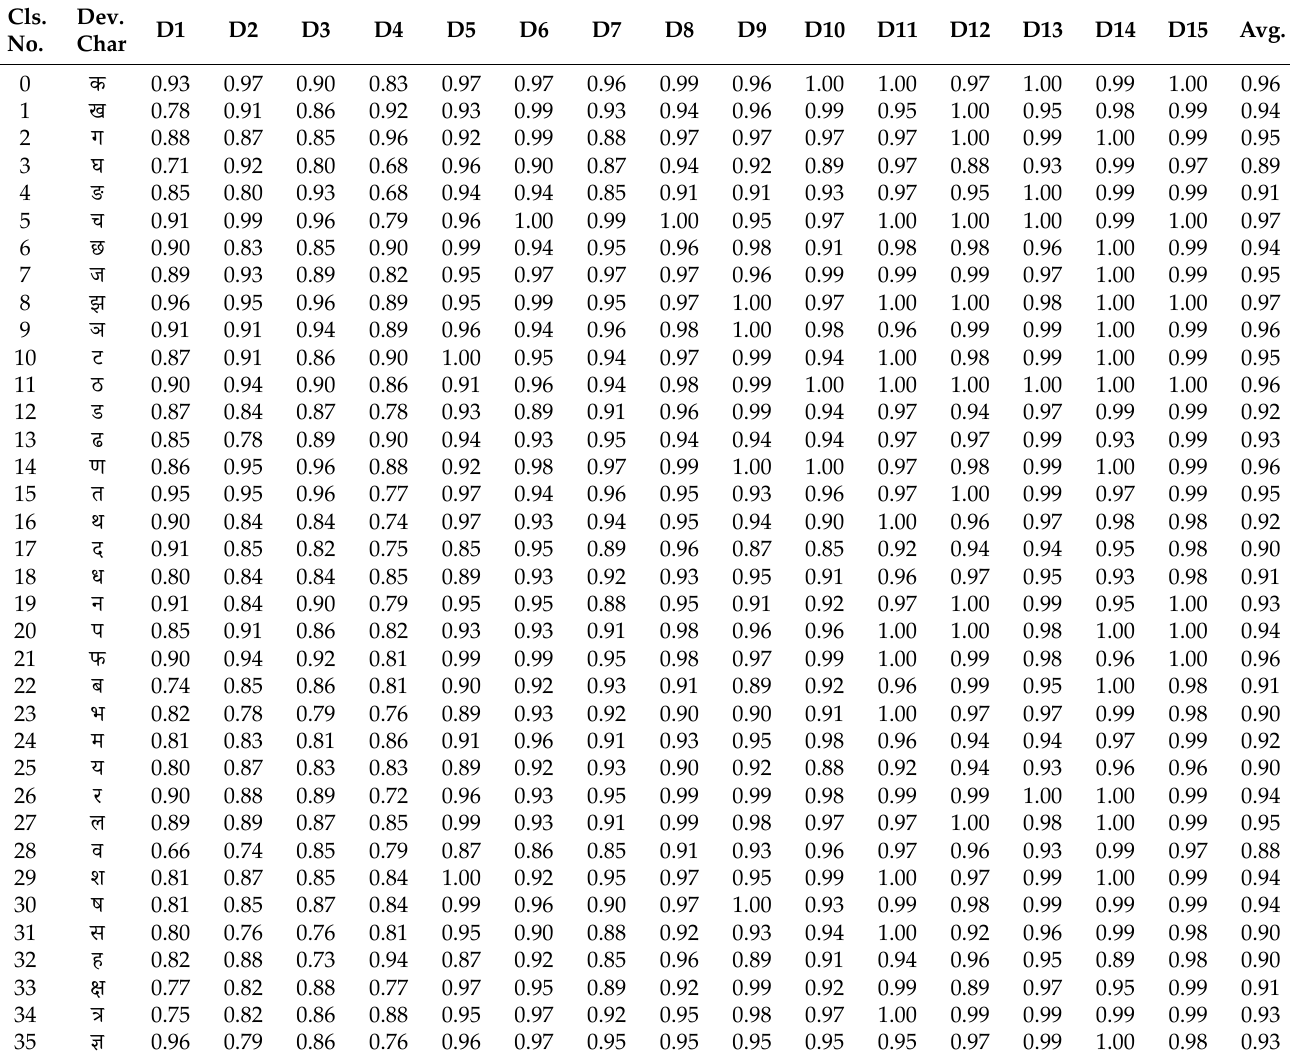
Table 7. Character‑wise precision produced by an MLP classifier for the proposed datasets.